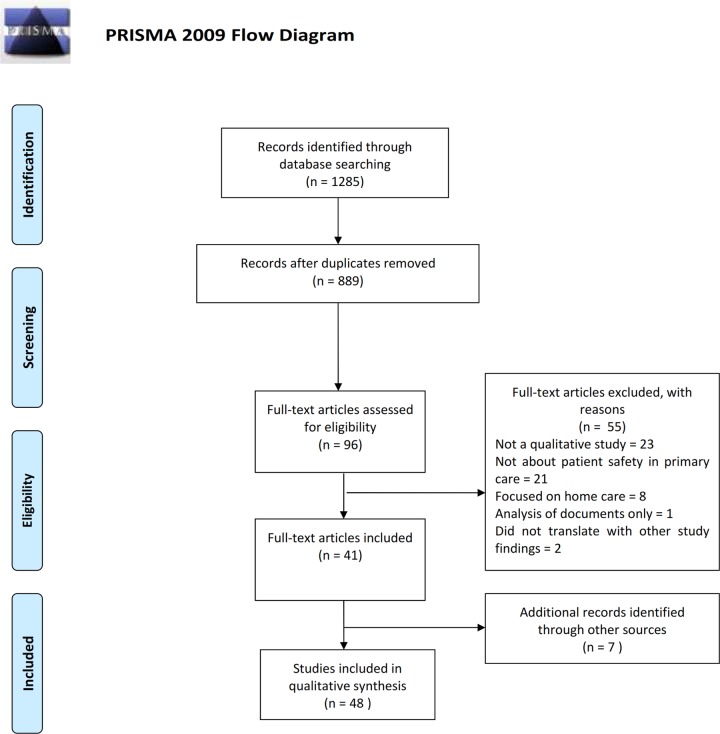
Prisma Flowchart.